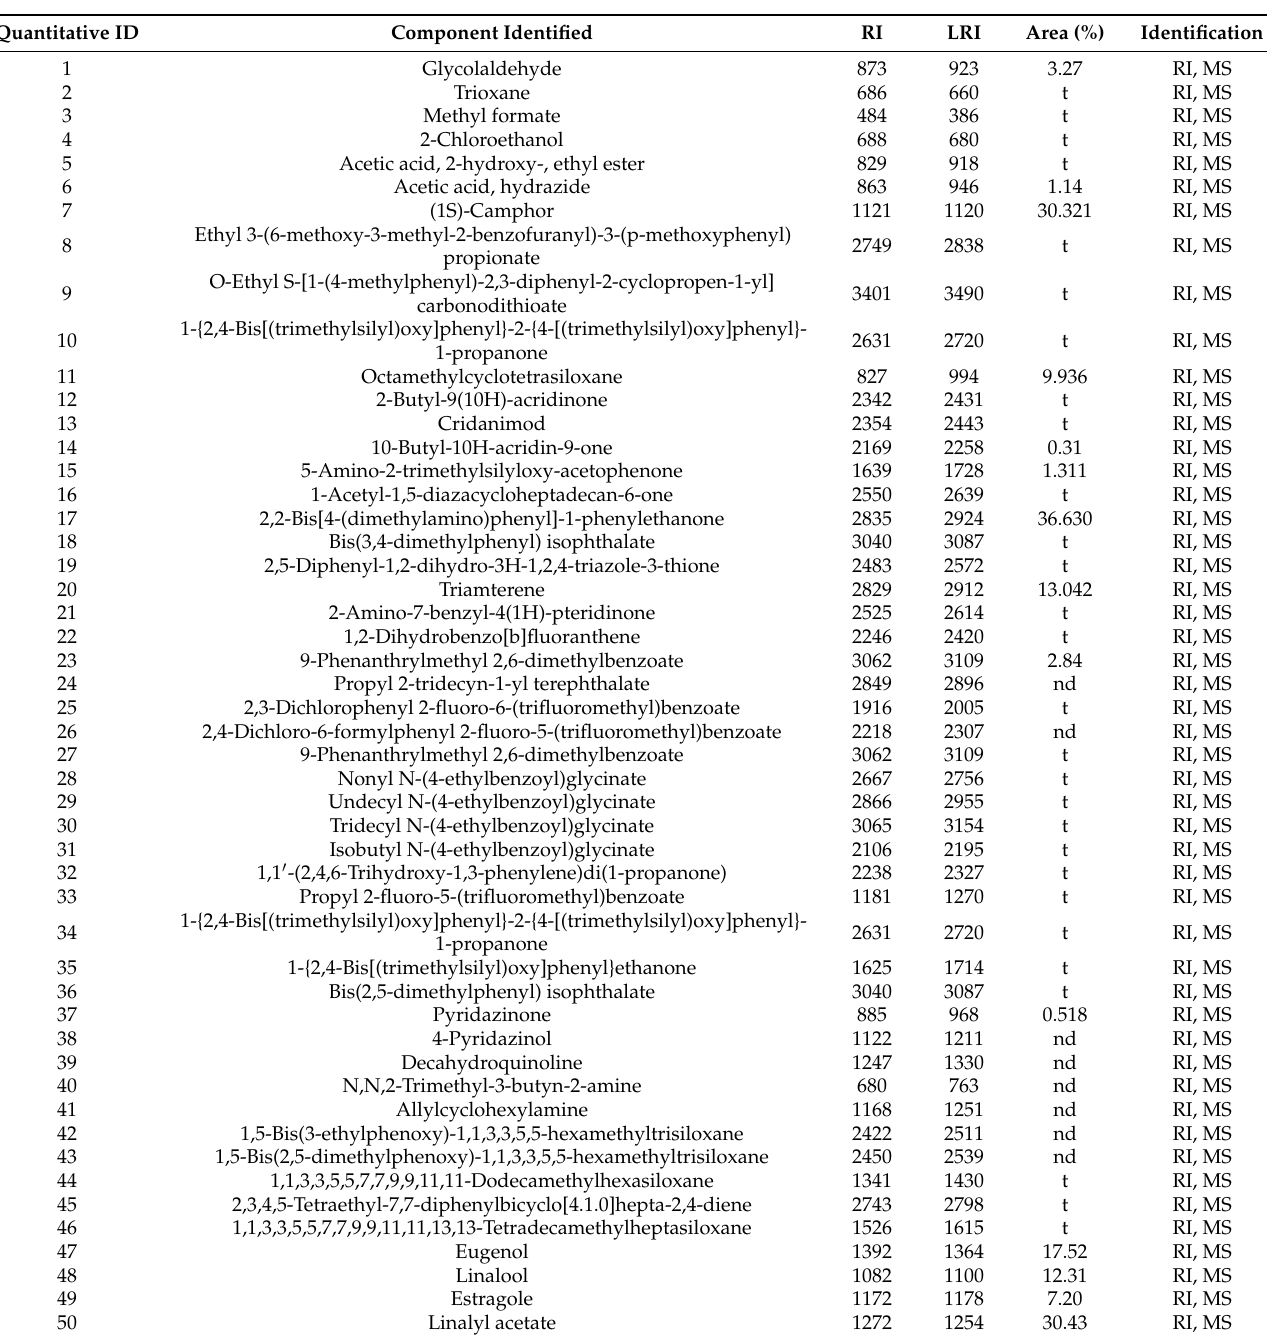
Table 3. Chemical composition of O. basilicum